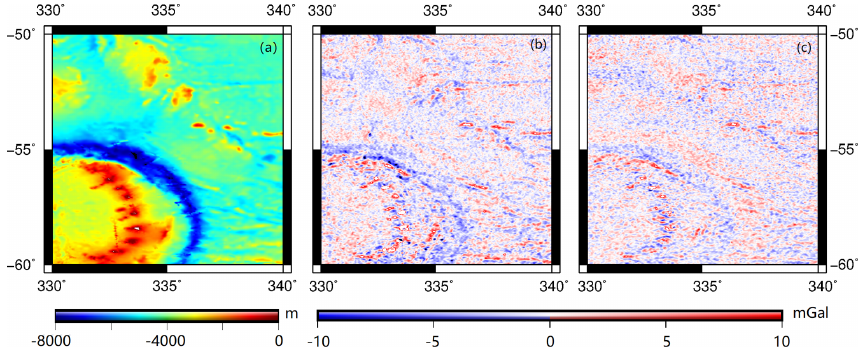
Figure 7. Topography and gravity information around South Sandwich Trench: (a) is the submarine topography, (b) is the figure of differ- ences between SDUST2021GRA and SIO V30.1, and (c) is for SDUST2021GRA and DTU17.